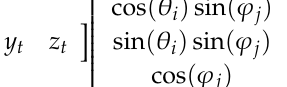
Figure 2. The graphical illustration of a Cartesian coordinate and a 3D Hough space. ( a ) The Cartesian coordinate. ( b ) The Hough space.